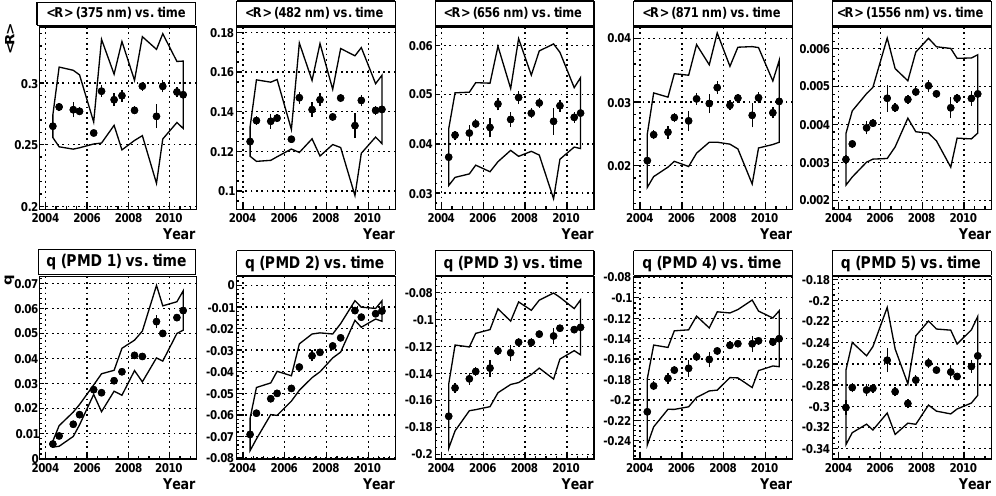
Fig. 5. Time dependence of the average reflectance and polarization. Points with error bars represent the mean and its error, the envelope the variance of the distribution. The data sample corresponds to the reference state 20, the average tangent height is 21.7km. This plot contains both the April and August data